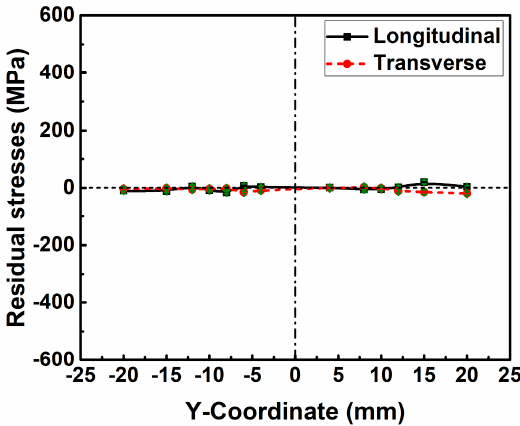
Figure 6. The measured distribution of longitudinal and transverse residual stress along line 1 after heat treatment. Table 2. Welding parameters. Table 1. Measured chemical composition of S355N steel.